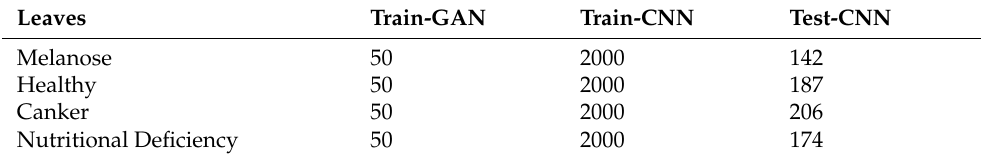
Table 1. The number of different species of leaves in each dataset.